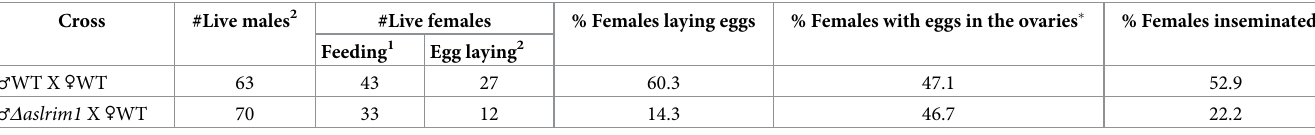
Table 2. Egg production in WT females and oviposition following a cross with Δ aslrim1 or WT males.